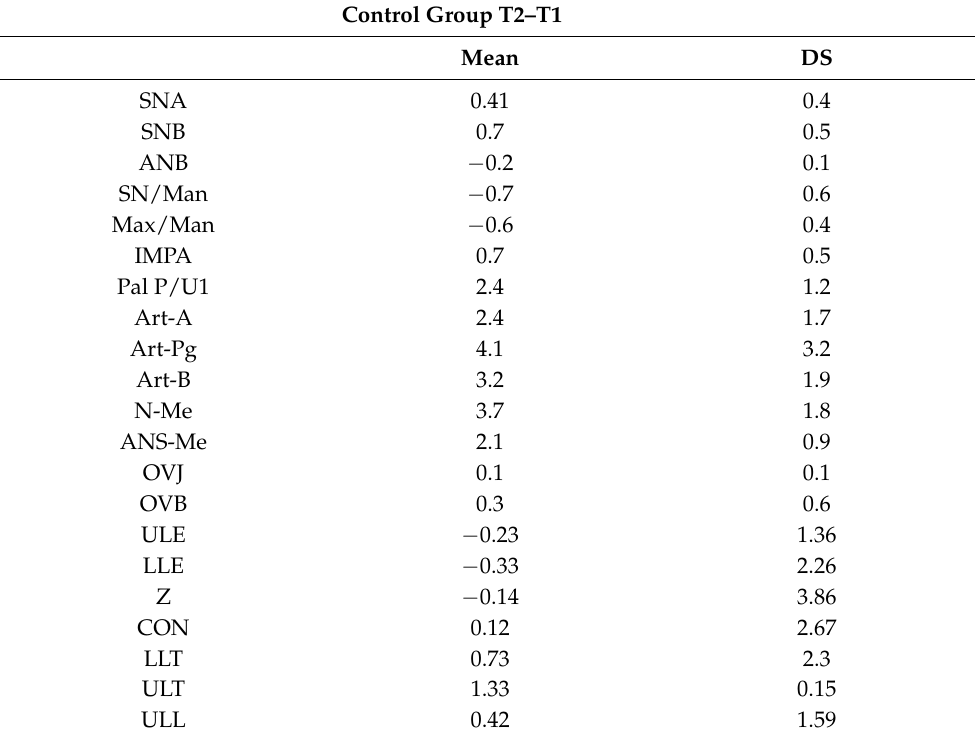
Table 6. Data collection of the differences in the variables considered between the time T1 and T2 for the control